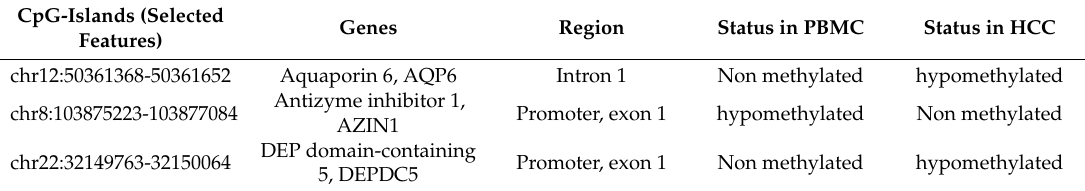
Table 3. Minimum number of features selected by ANOVA leading to a high accuracy of prediction. CpG-Islands (Selected